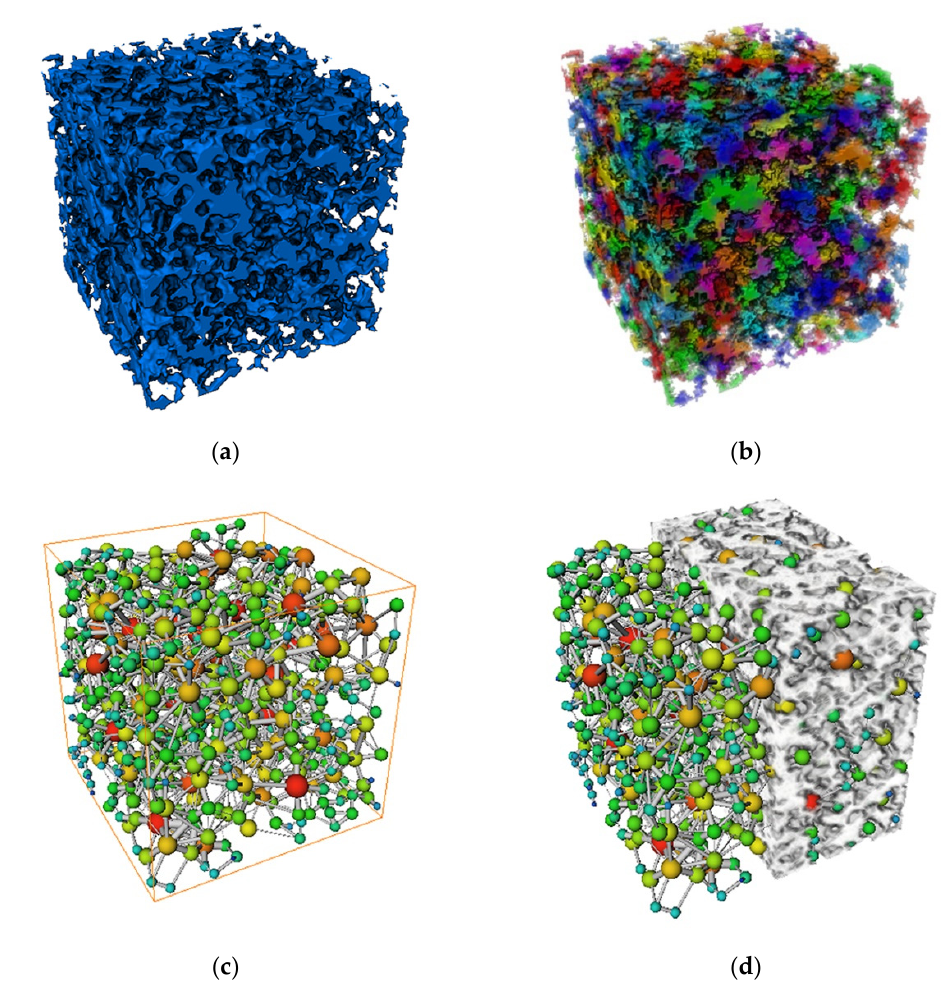
Figure 10. Construction of the PNM model: ( a ) Pore structure model; ( b ) Segmentation model; ( c ) PNM model; ( d ) PNM-material matrix.